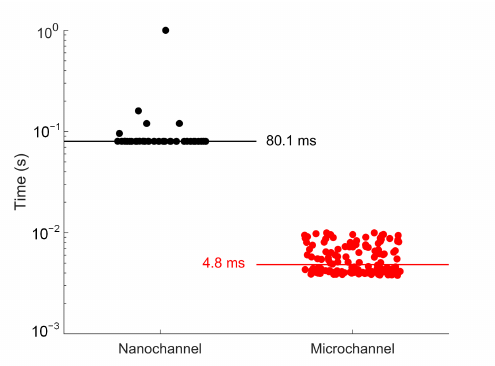
Figure 9. The time to locate a new molecule during the SMR experiment. The horizontal line in each scatter plot represents the median of the